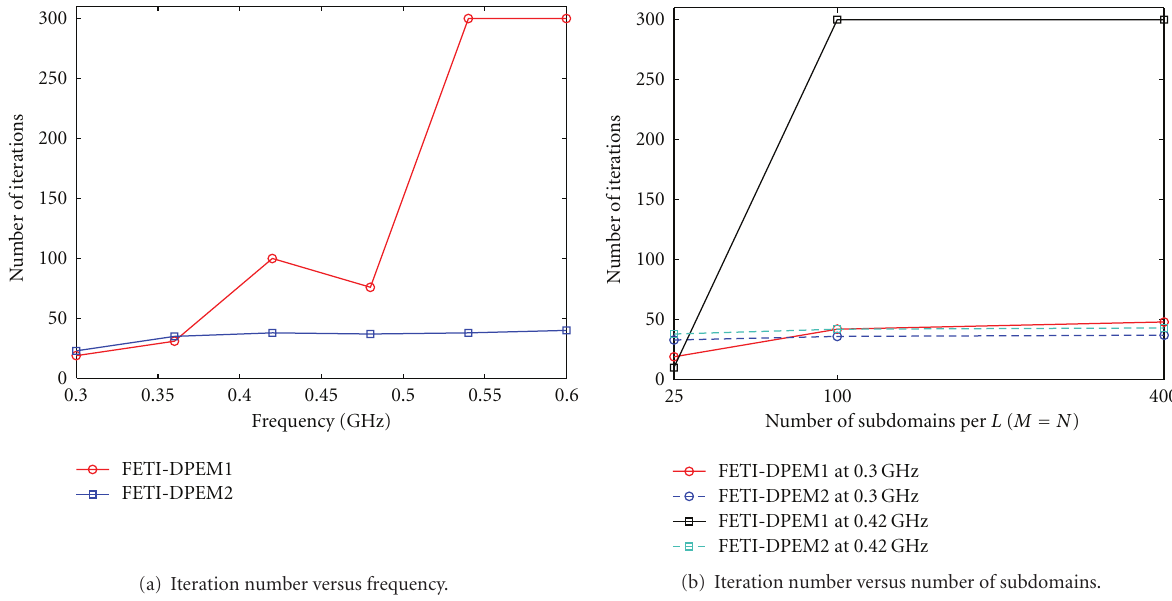
Figure 3: Iteration number required by FETI-DPEM1 and